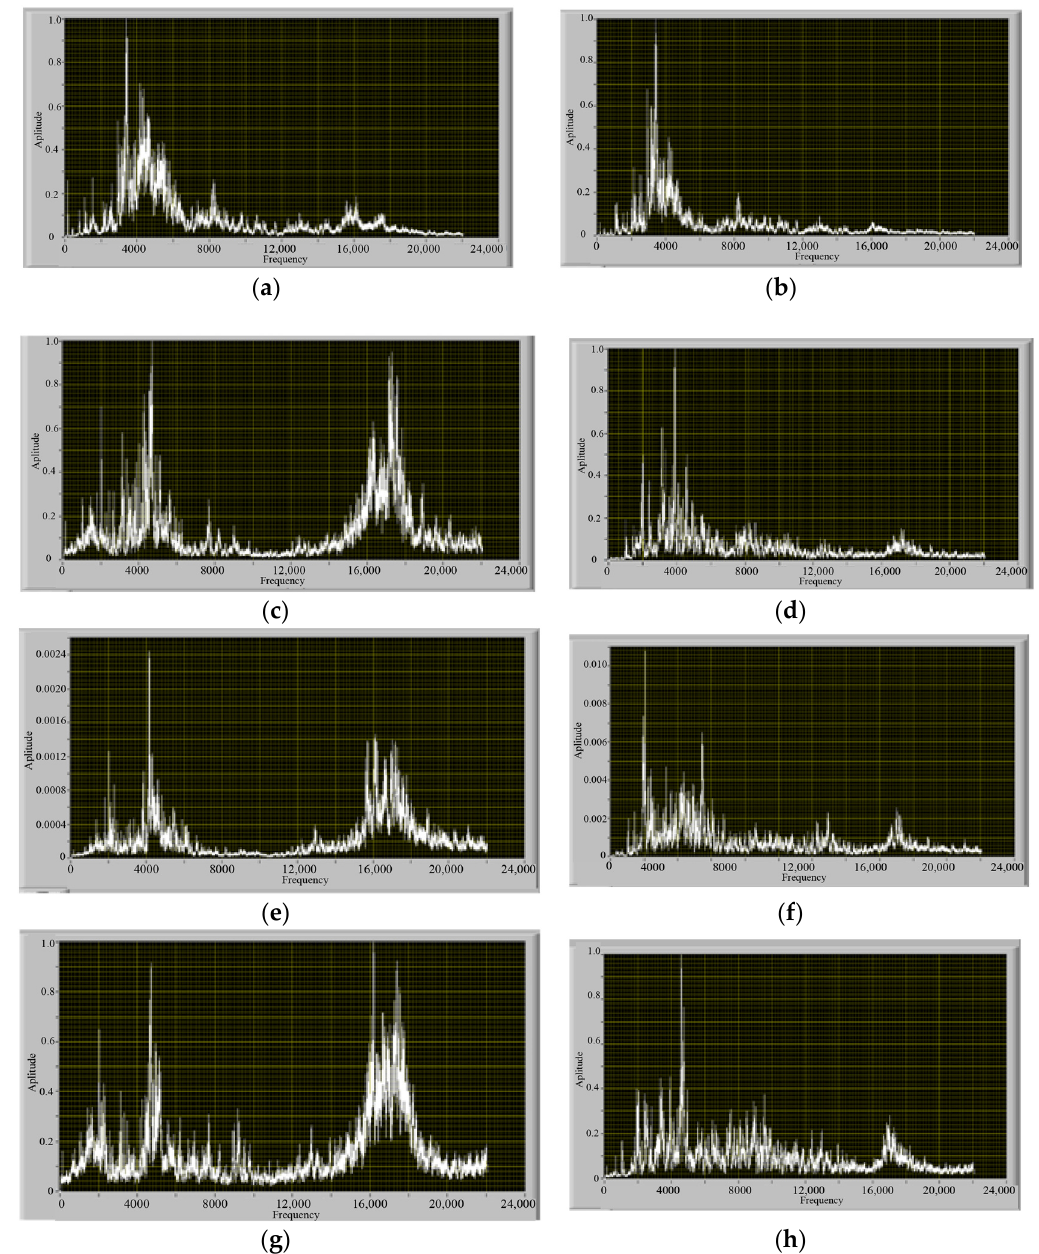
Figure 4. Oscillation spectra of a defect-free pipeline: ( a ) signal along the X-axis at a pressure of 4 atm; ( b ) signal along the Y-axis at a pressure of 4 atm; ( c ) signal along the X-axis at a pressure of 3 atm; ( d ) signal along the Y-axis at a pressure of 3 atm; ( e ) signal along the X-axis at a pressure of 2 atm; ( f ) signal along the Y-axis at a pressure of 2 atm.